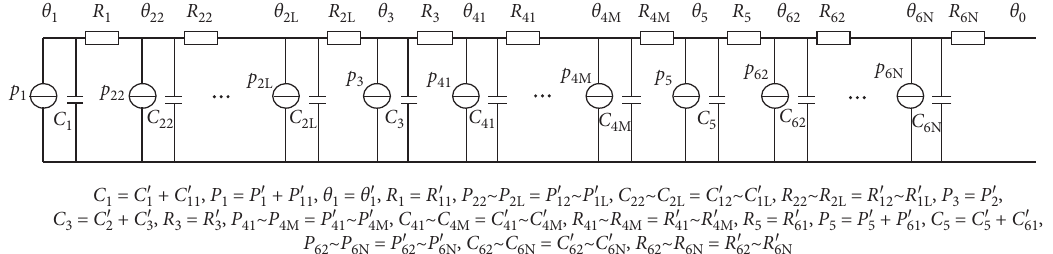
Figure 9: Simplification of layered trisection transient thermal circuit model of power